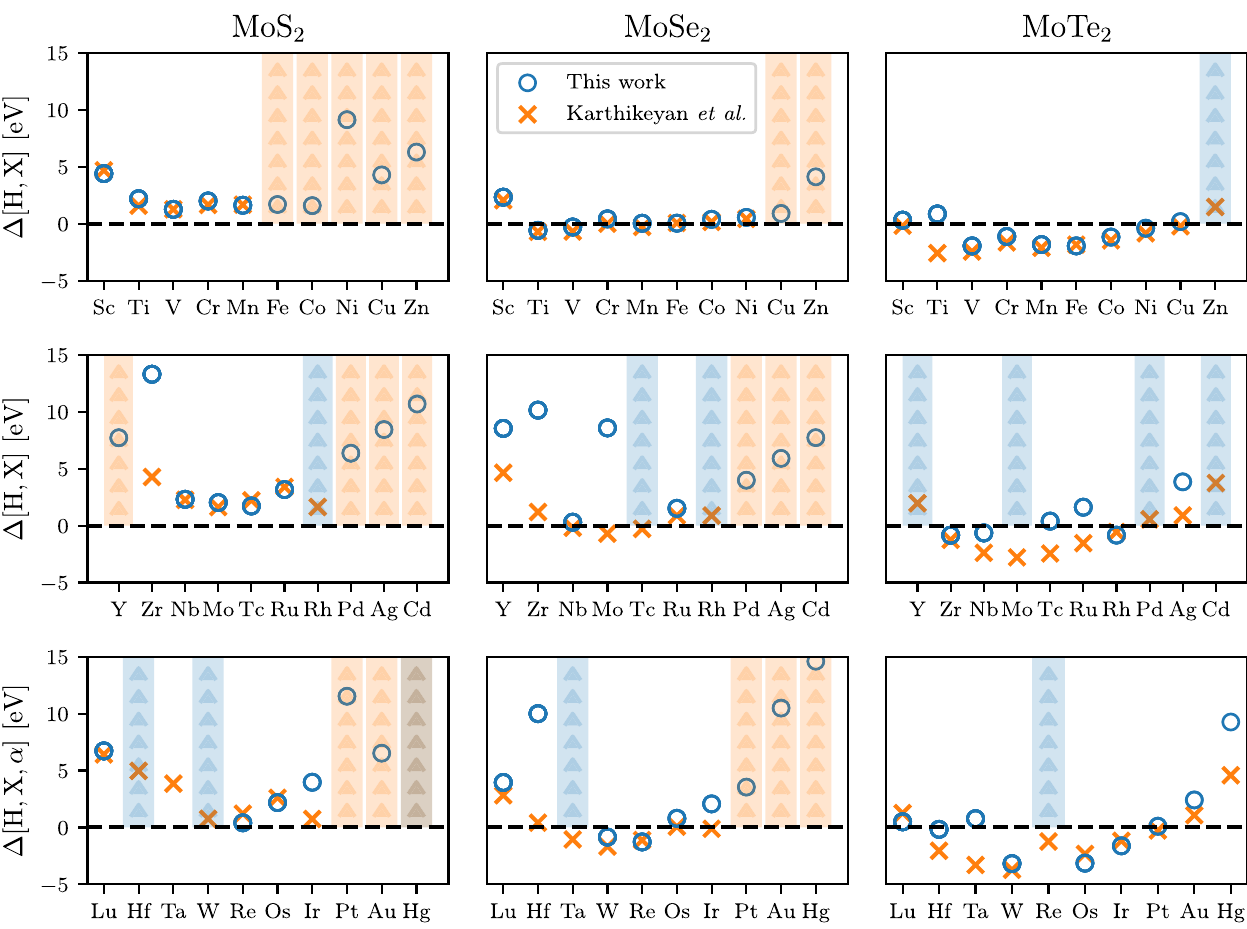
Fig. 2 Transition metal doping in transition metal dichalcogenides 2H-MoX 2 . Δ H ; X ½ (cid:2) values for transition metal-doped MoS 2 (left column), MoSe 2 (middle column) and MoTe 2 (right column) as a function of the doping element. The blue circles and blue bars show our calculated values whereas the orange crosses and orange bars are reference values for the same systems extracted from Ref. 30 . The colored bars represent systems where not both adsorption sites and interstitial positions